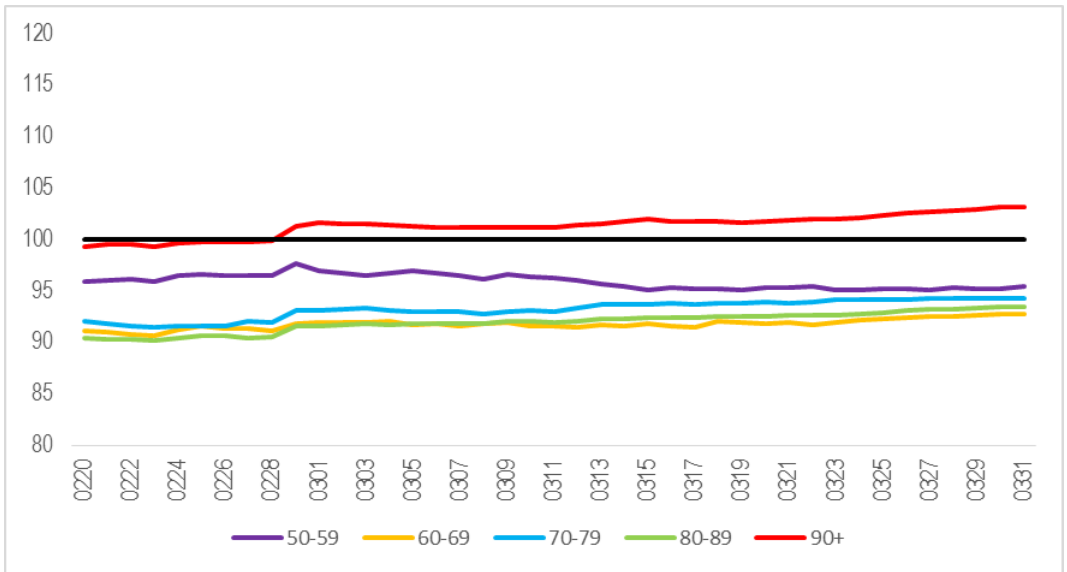
Figura 5. Decessi cumulati a partire dal primo gennaio per classe di età. Per 100 decessi della stessa classe di età della media 2015-2019. Province con basso livello di diffusione Covid-19. Periodo: